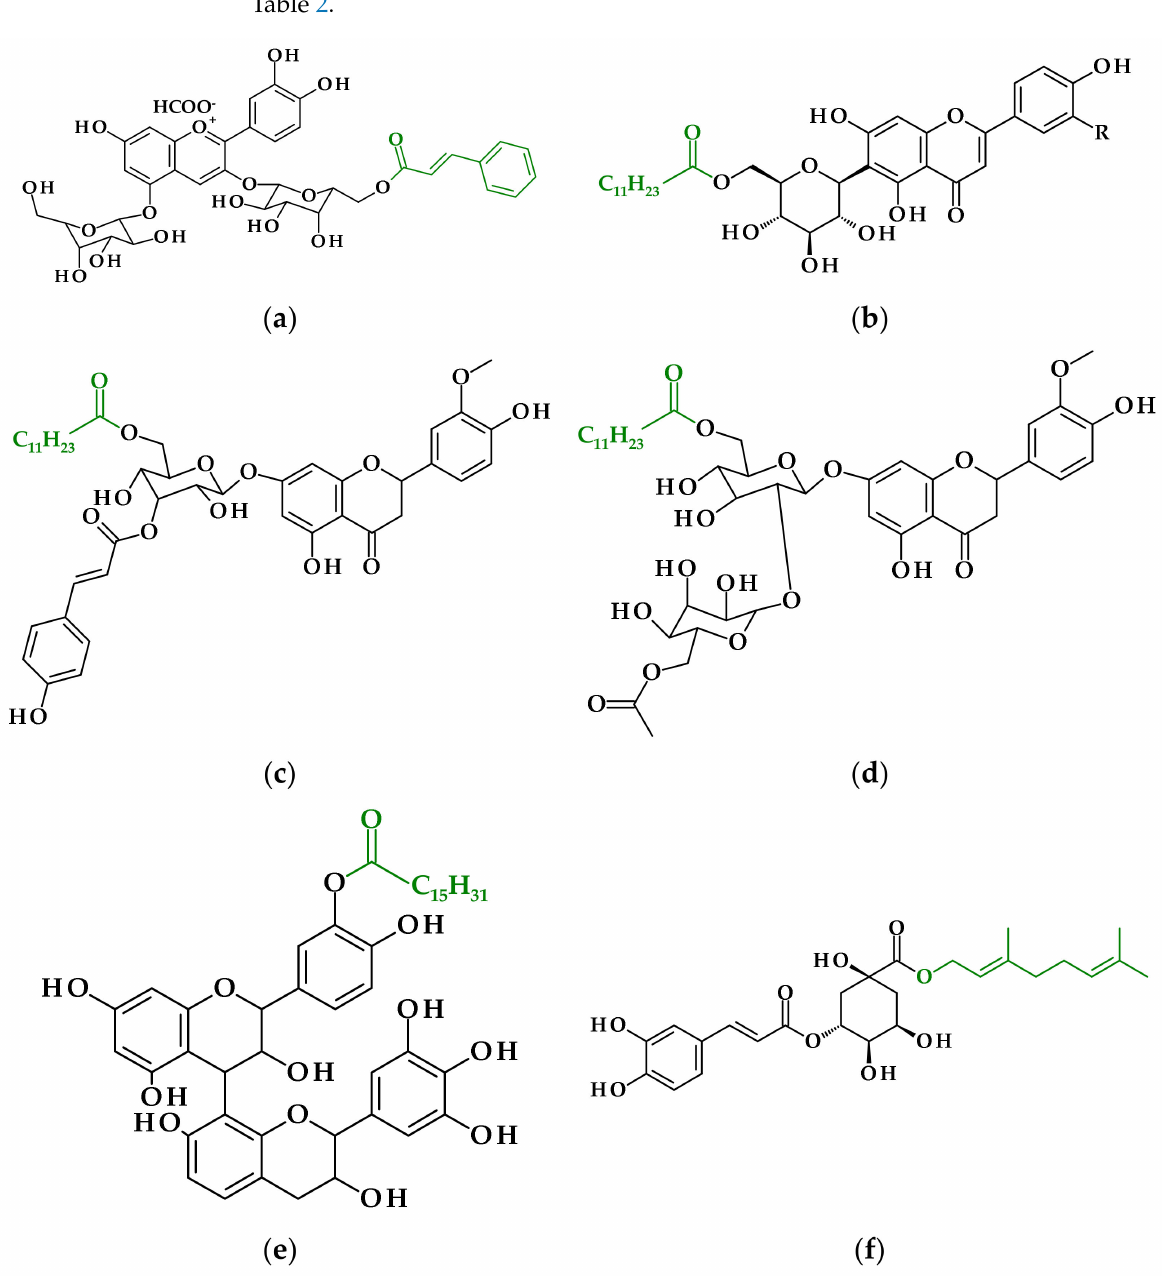
Enzyme-assisted derivatizations of phenolics present in flower extracts are summarized in